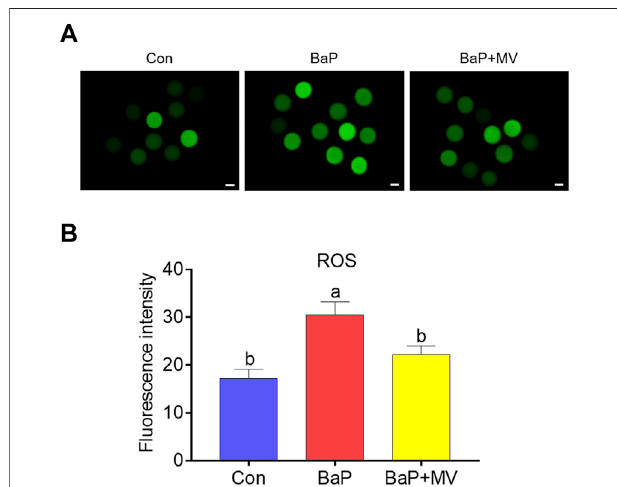
FIGURE 5 | Effects of MV on ROS levels in the oocytes of BaP-exposed mice. Intracellular ROS content was measured using a dichlorodihydro fl uorescein diacetate probe (DCFH-DA). (A) Representative images of ROS signals in Con, BaP and BaP + MV oocytes. (B) The fl uorescence intensity of ROS in the Con, BaP and BaP + MV groups. Scale bar (cid:2) 20 μ m. The data are presented as the mean ± SEM. a-c Means not sharing a common superscript are signi fi cantly different ( p < 0.05).